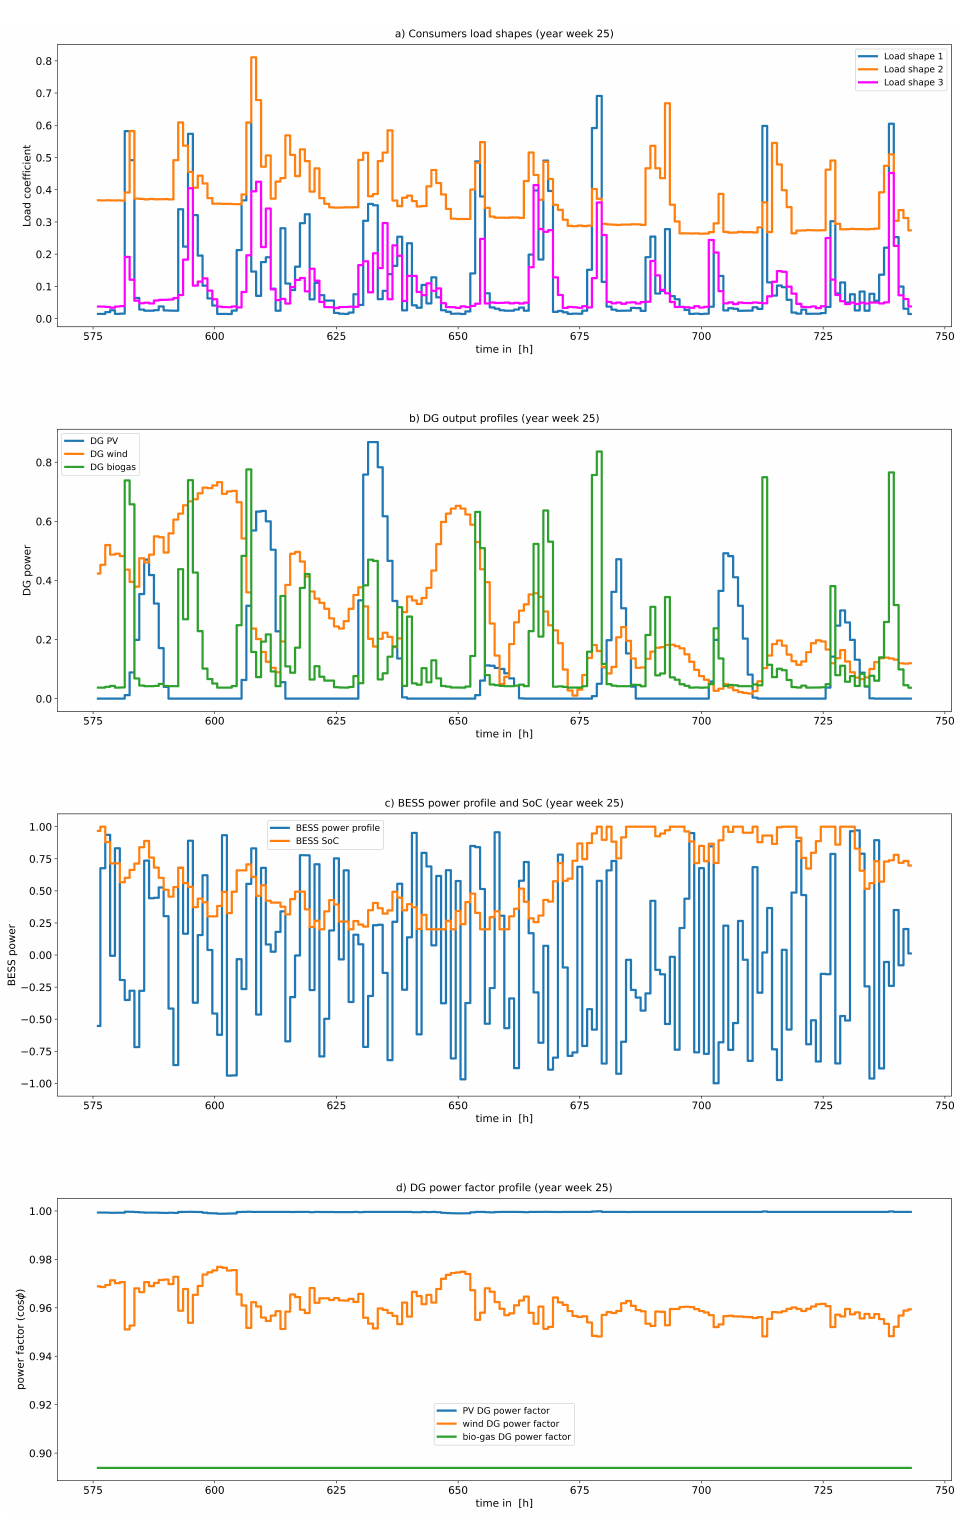
Figure 6. Load, DG and BESS profiles for 25th week in year: ( a ) Consumers load shapes, ( b ) DG output profiles, ( c ) BESS power profile and SoC, ( d ) DG power factor